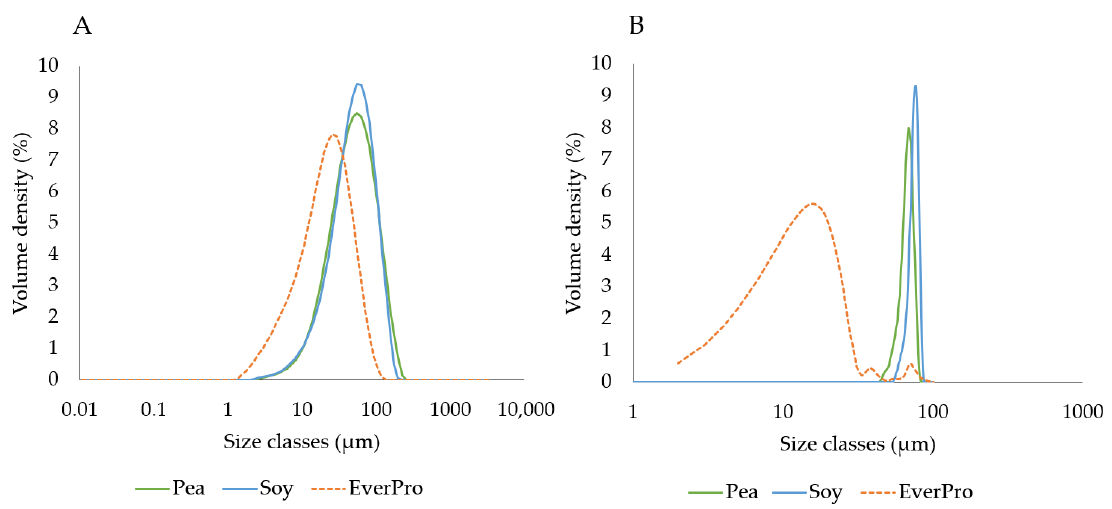
Figure 3. The dry ( A ) and wet ( B ) particle size dispersion for pea, soy and EverPro, displayed as volume density (%) per size class ( μ m).